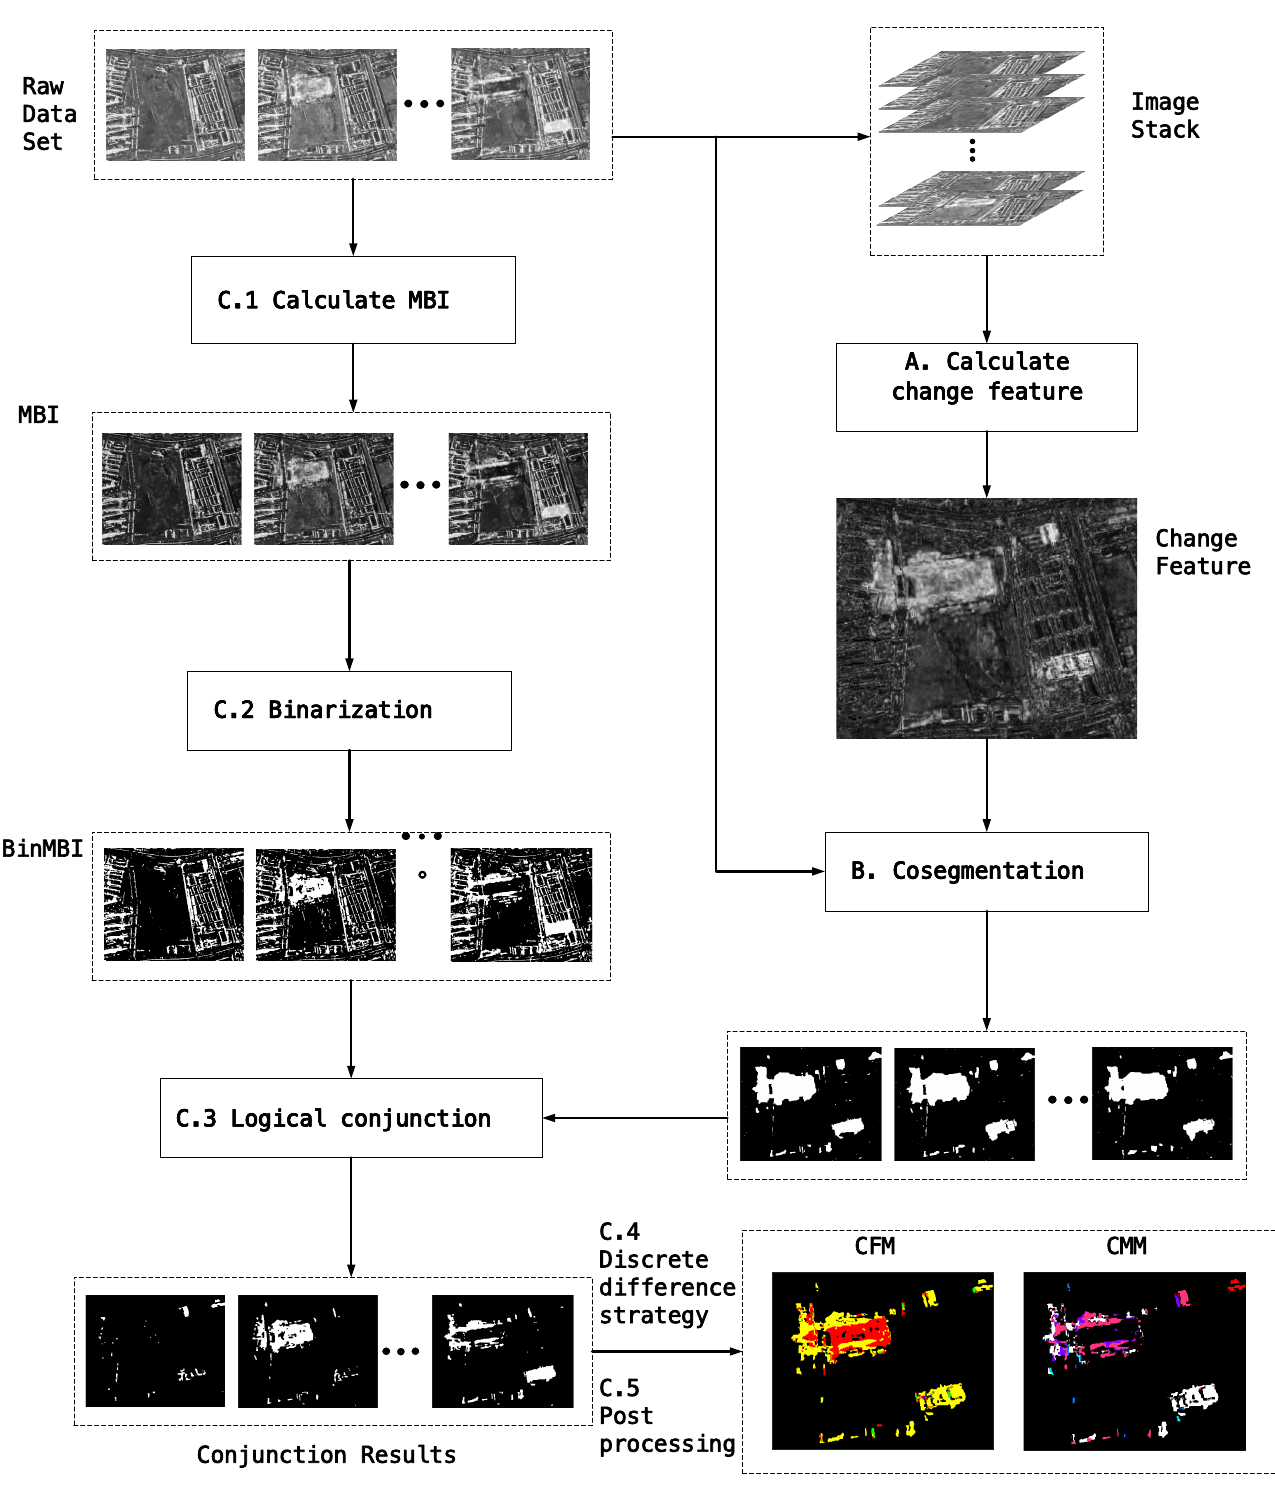
Figure 1. The workflow of the proposed